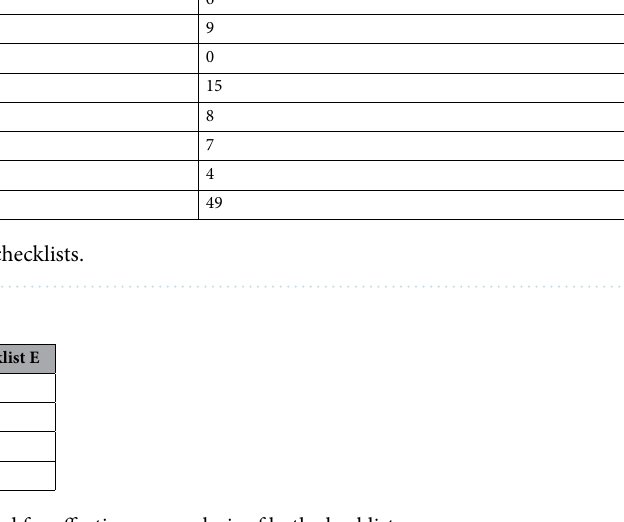
Table 7. Statistical T-test results obtained for effectiveness analysis of both